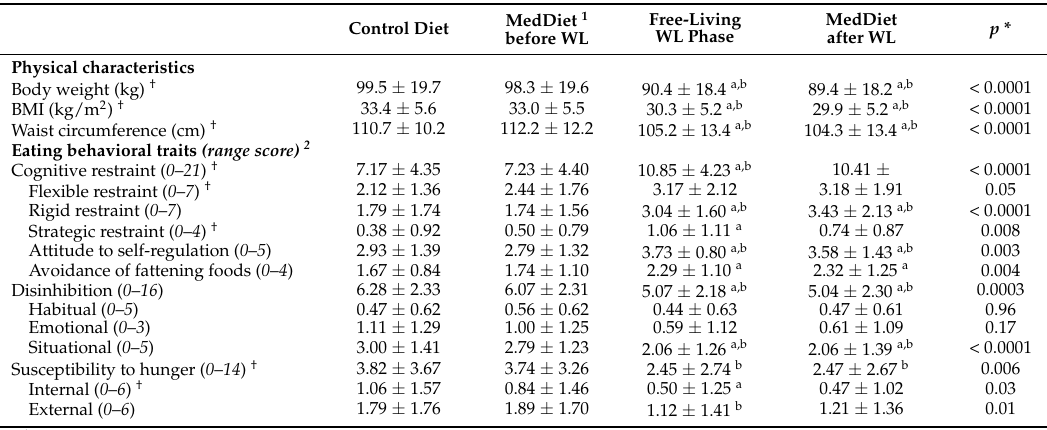
Table 3. Physical characteristics and eating behavioral traits measured at the end of the different phases of the